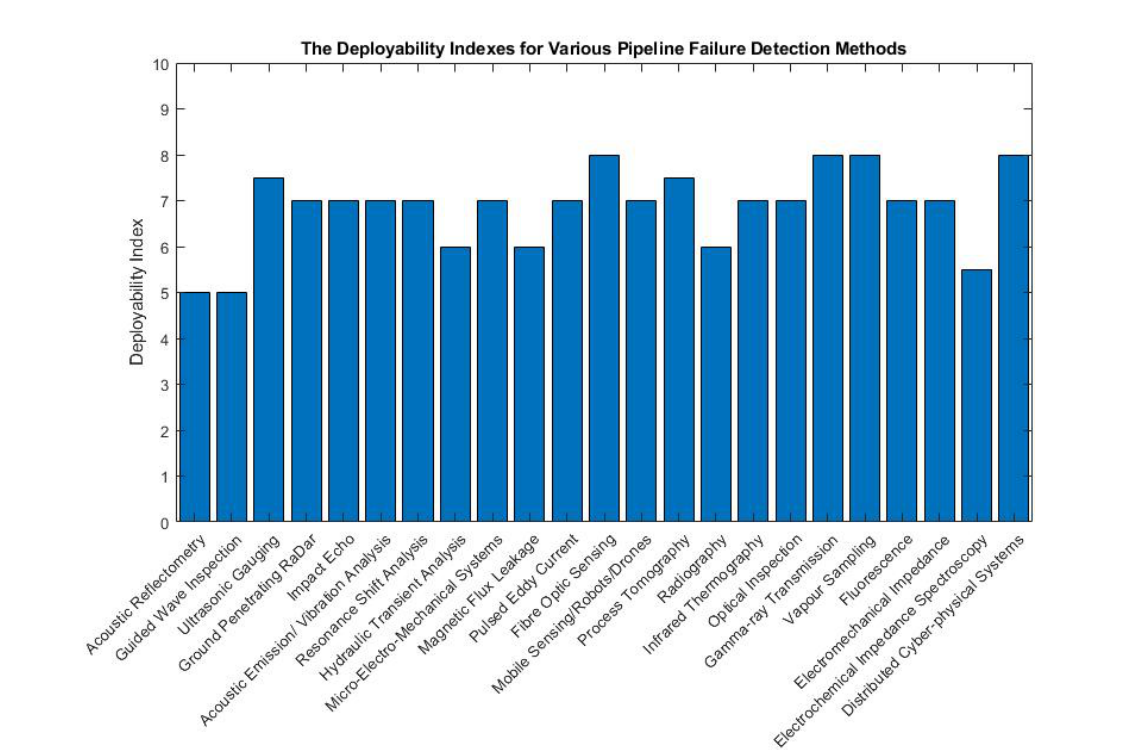
Figure 64. The deployability indexes for various pipeline failure detection methods.